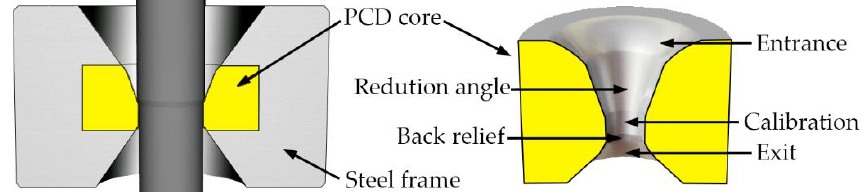
Figure 2. Construction of the dies ( Ø 43 x 25 mm steel frame) and geometry of the PCD (polycrystalline diamond) core.